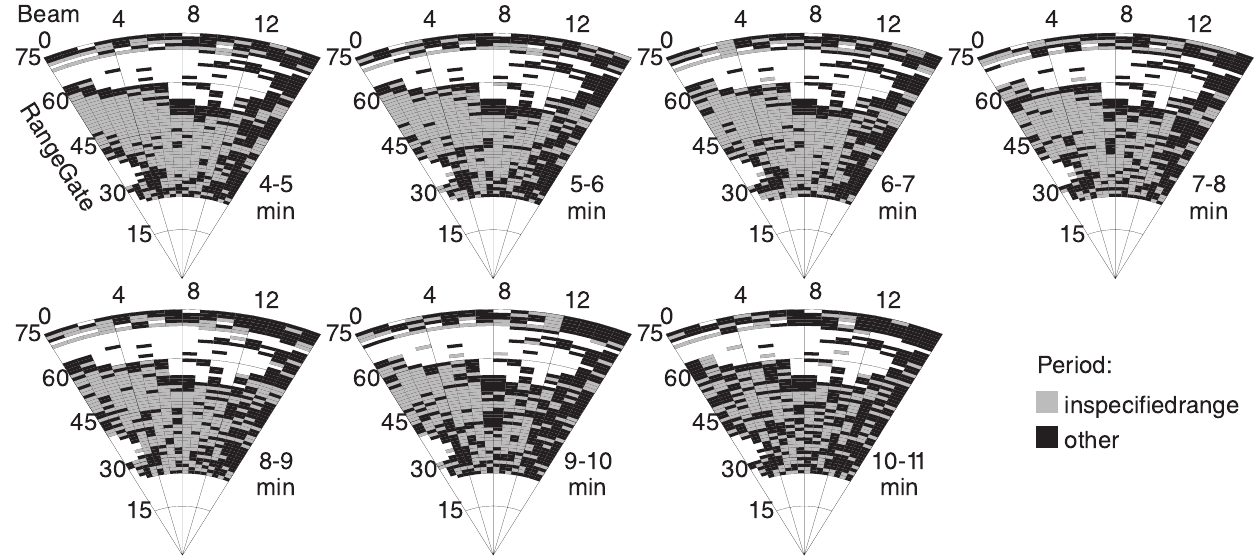
minimum power threshold are coloured black . The grey range cells are where the FFT analysis has found periods within the specified one-minute interval. A clear grouping of range cells with similar periods can be seen between range gates 30 and 60 and extending across beams 0